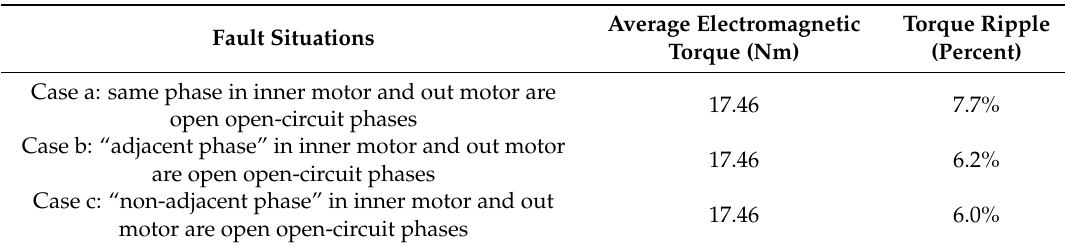
Figure 18. The motor operates under single-phase open-circuit in both inner motor and outer motor conditions: ( a ) electromagnetic torque obtained by FEA; ( b ) the torque produced by outer motor and inner motor, respectively. Table 10. The details of electromagnetic torque of the three fault cases under single-phase open-circuit in both inner motor and outer motor fault types.